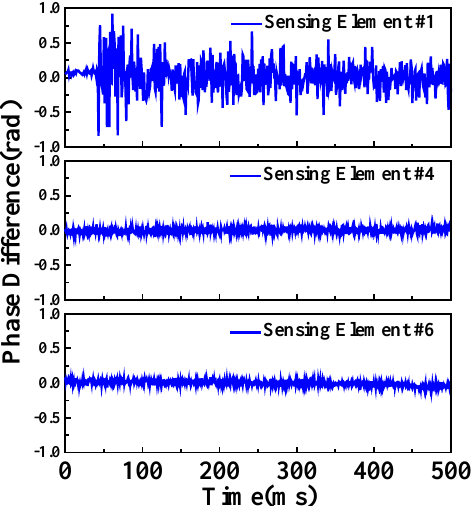
Figure 8. Detected signals of sensing elements #1, #4, and #6 at a pulse repetition rate of 2 kHz.